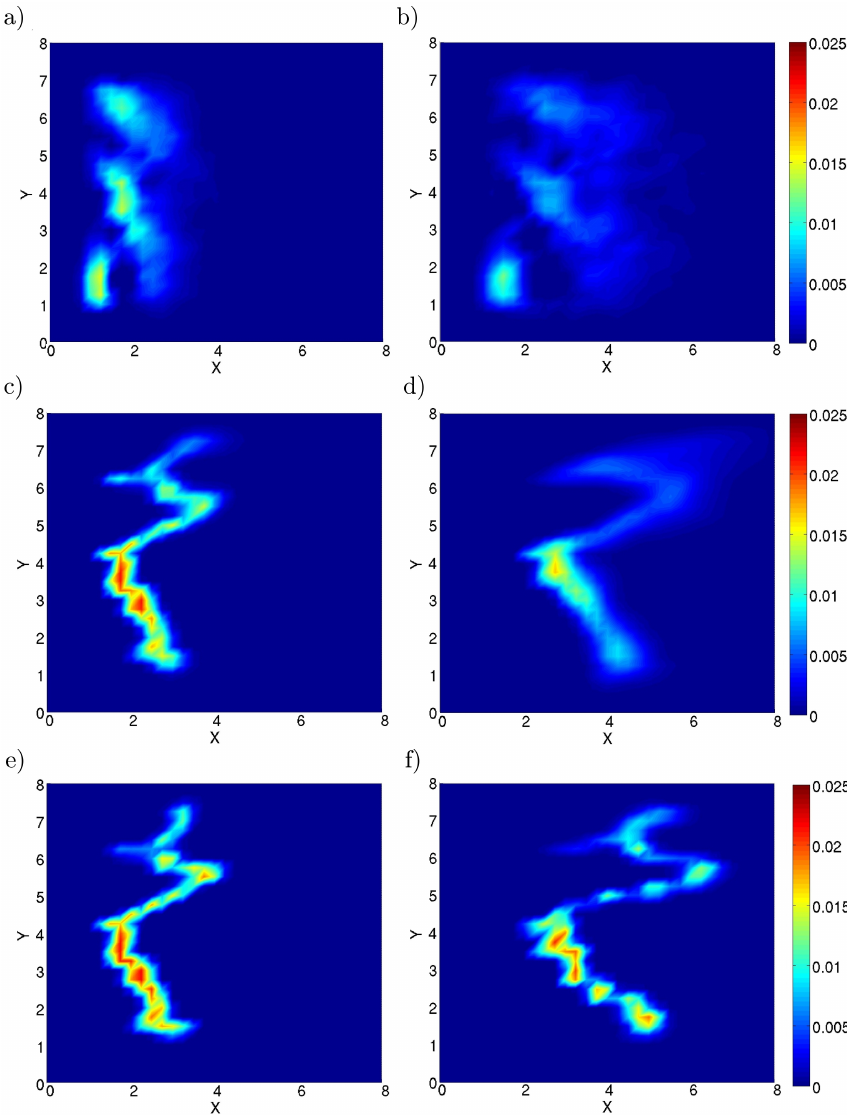
Fig. 11. Ensemble mean of the plume evolution at a) t = 2 T and b) t = 4 T in the prior Y fields, at c) t = 2 T and d) t = 4 T in the Y field estimated at t = 2 T by the EnKF in scenario 1a and at e) t = 2 T and f) t = 4 T in the Y field estimated at t = 4 T by the EnKF in scenario 1a. The color bar indicates concentration values.